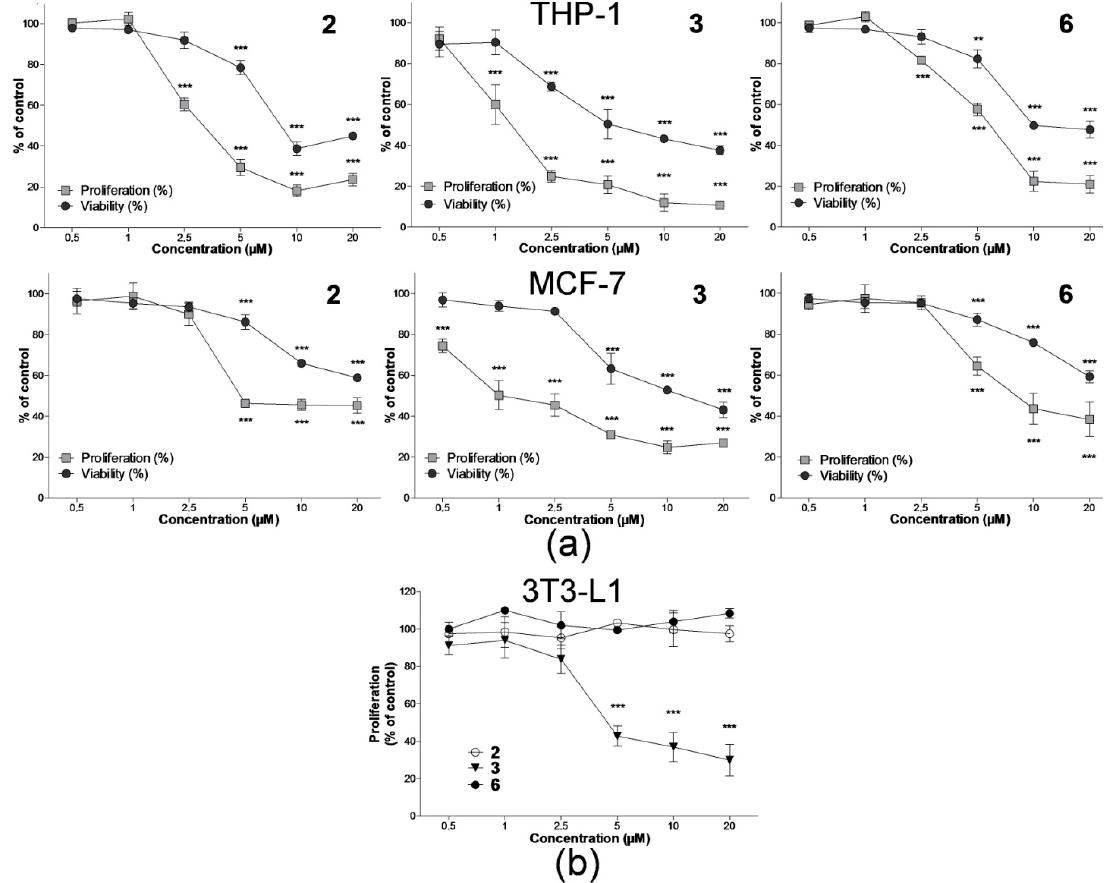
Figure 1. Effect of compounds 2 , 3 , and 6 on cell proliferation and viability in THP-1, MCF-7 and 3T3-L1 cell lines. Cells were cultured with indicated concentrations of compounds 2 , 3 , and 6 for 24 h. ( a ) Proliferation of THP-1 and MCF-7 cells was determined using WST-1 assay; cell viability was assessed by erythrosin B exclusion test; ( b ) Proliferation of 3T3-L1 cells was determined using WST-1 assay. The results are shown as the means ± standard deviation (SD) of three independent experiments, each performed in triplicate. ** p < 0.01, *** p < 0.001, statistically significant difference in comparison with drug-free control (CTRL).